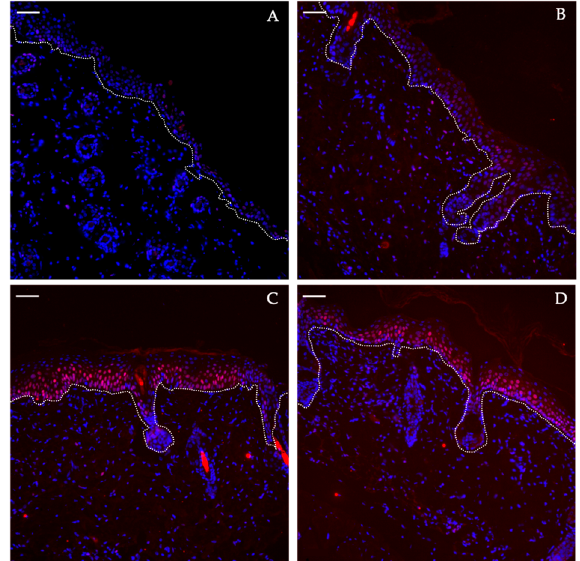
Figure 5. pSTAT3 staining evaluation on dorsal skin in the course of IMQ-induced psoriasis-like dermatitis at day 2 ( A ), day 4 ( B ), day 6 ( C ) and day 8 ( D ). The dotted white line represents the dermo-epidermal junction with epidermis upwardly. pSTAT3 protein appears in red and cell nuclei in blue. Scale bar = 50 μ m.